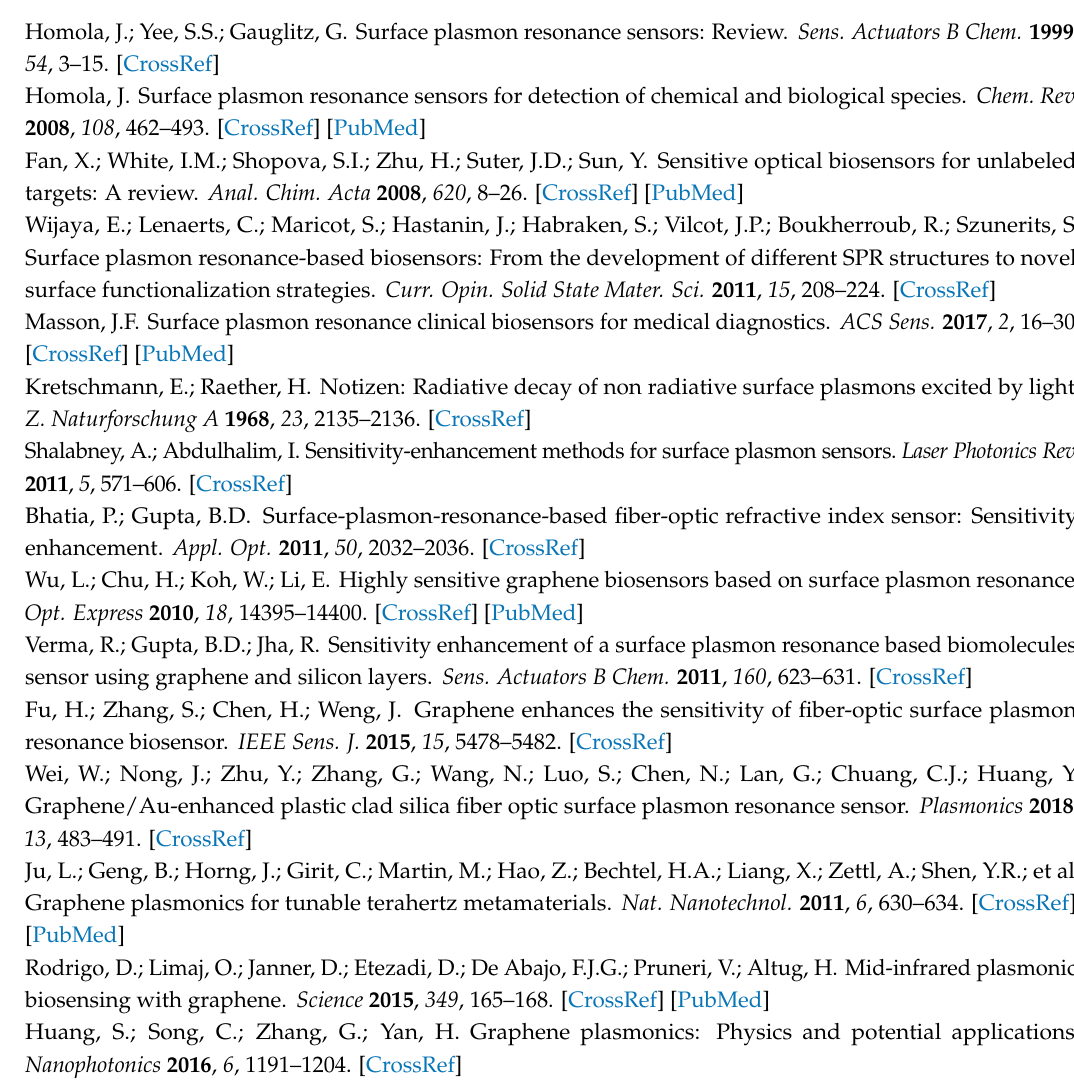
Figure S1: Reflectance for the Ti 3 C 2 T x -MoSe 2 -based SPR sensor; Figure S2: Reflectance for the Ti 3 C 2 T x -WS 2 -based SPR sensor; Figure S3: Reflectance for the Ti 3 C 2 T x -WSe 2 -based SPR sensor; Figure S4: Variation of sensitivity with number of MoSe 2 and Ti 3 C 2 T x layers for the Ti 3 C 2 T x -MoSe 2 -based SPR sensor; Figure S5: Variation of sensitivity with number of WS 2 and Ti 3 C 2 T x layers for the Ti 3 C 2 T x -WS 2 -based SPR sensor; Figure S6: Variation of sensitivity with number of WSe 2 and Ti 3 C 2 T x layers for the Ti 3 C 2 T x -WSe 2 -based SPR